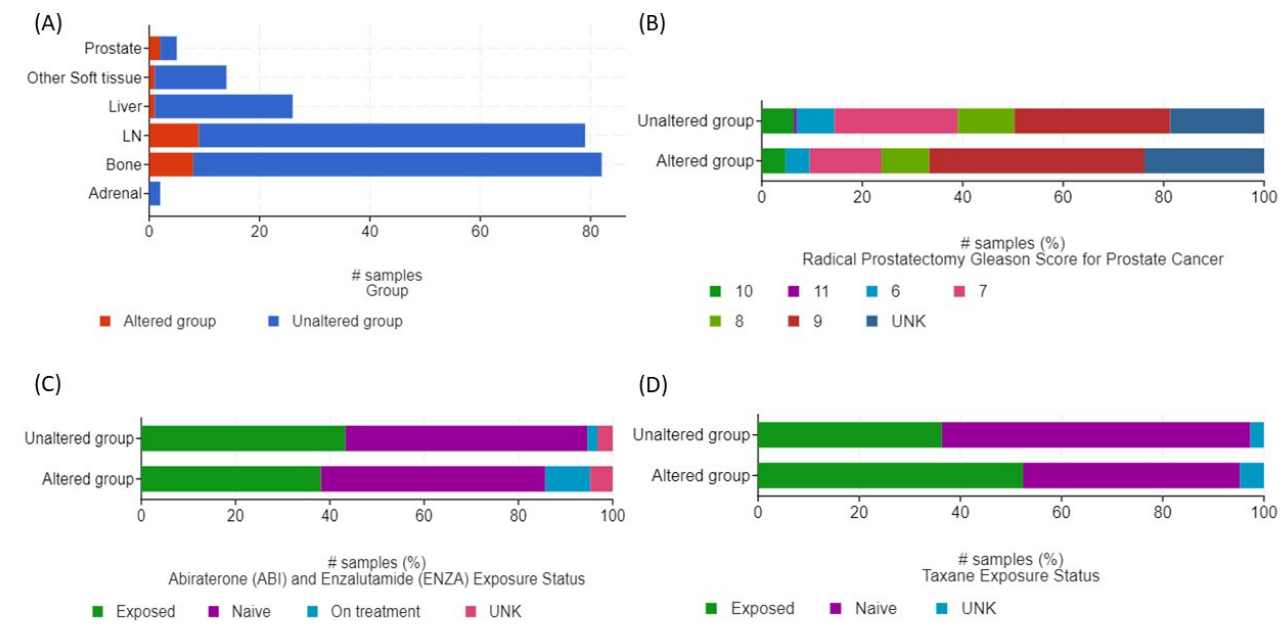
Figure 3. Distribution of mCRPC patients with altered (high) and unaltered tumor FAP mRNA expres- sion according to ( A ) tumor biopsy sites, ( B ) Gleason scores at RP, ( C ) abiraterone and enzalutamide exposure status, and ( D ) taxane exposure status. #: number